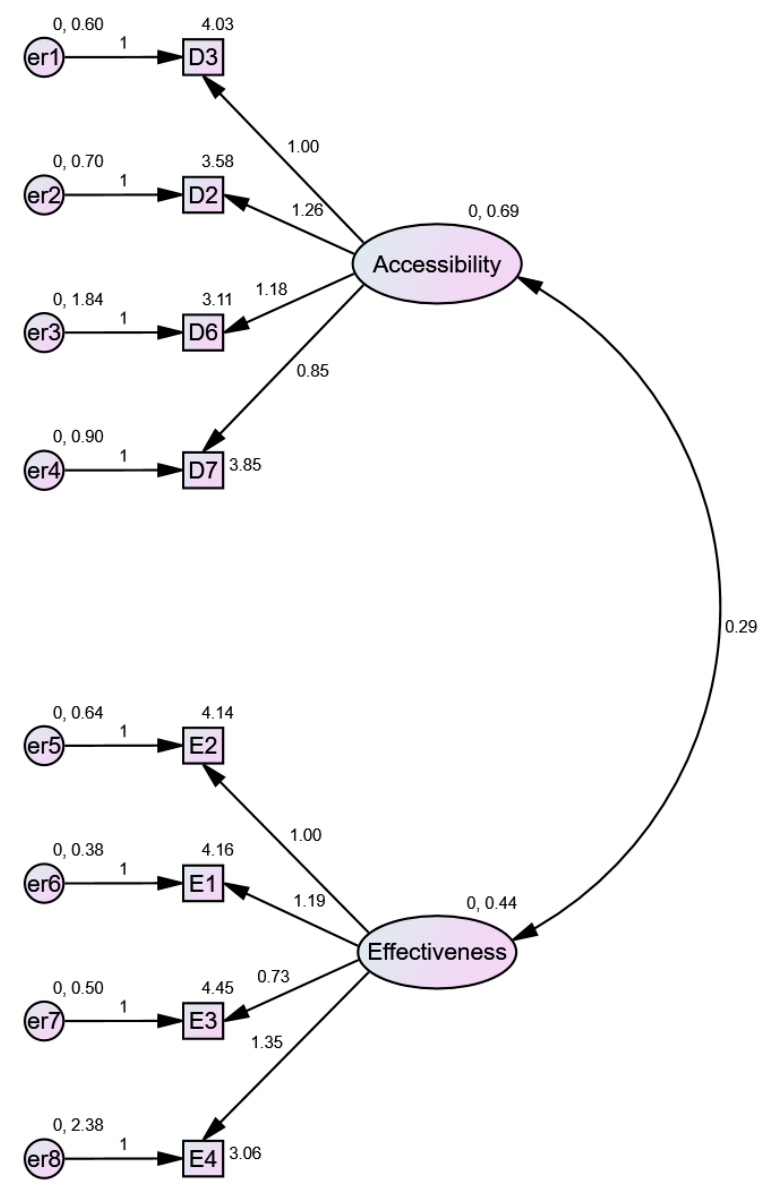
Figure 4. CFA model for the treatment effectiveness and the healthcare services accessibility during the COVID 19 pandemic (non-standardised estimates).